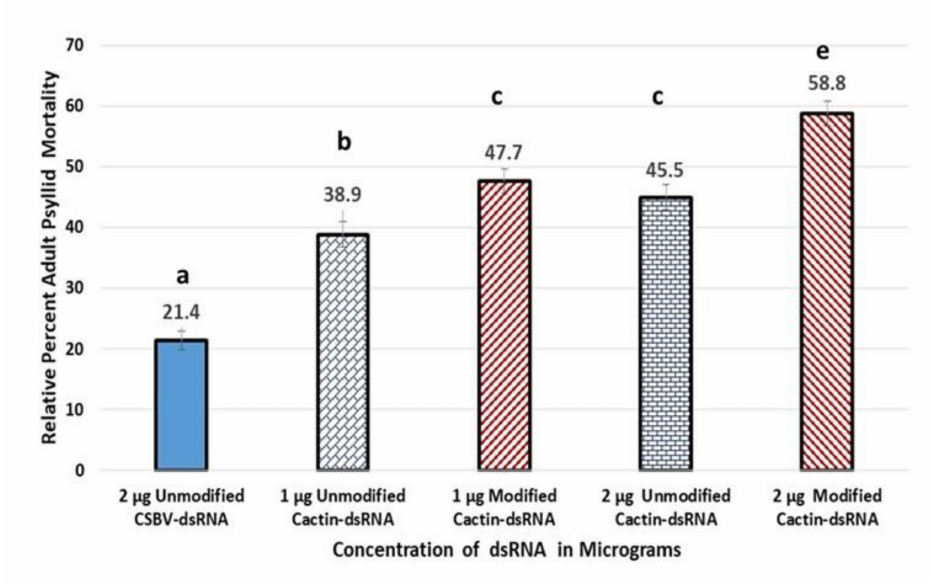
Figure 6. Percent Mean Psyllid Mortality at 8-d feeding access period on citrus cuttings treated with modified-pyrimidines in the dsRNA, or unmodified cactin -dsRNA at two concentrations. There was statistically significant differences between group means, as determine by one-way ANOVA, ( p < 0.01), followed with means separation post-hoc Tukey ( p ≤ 0.05). Error bars represent ± SE of the mean as determined from nine biological replicates (n = 9), with three technical replicates. Experiment repeated three times. Treatments with the same letter are not significantly